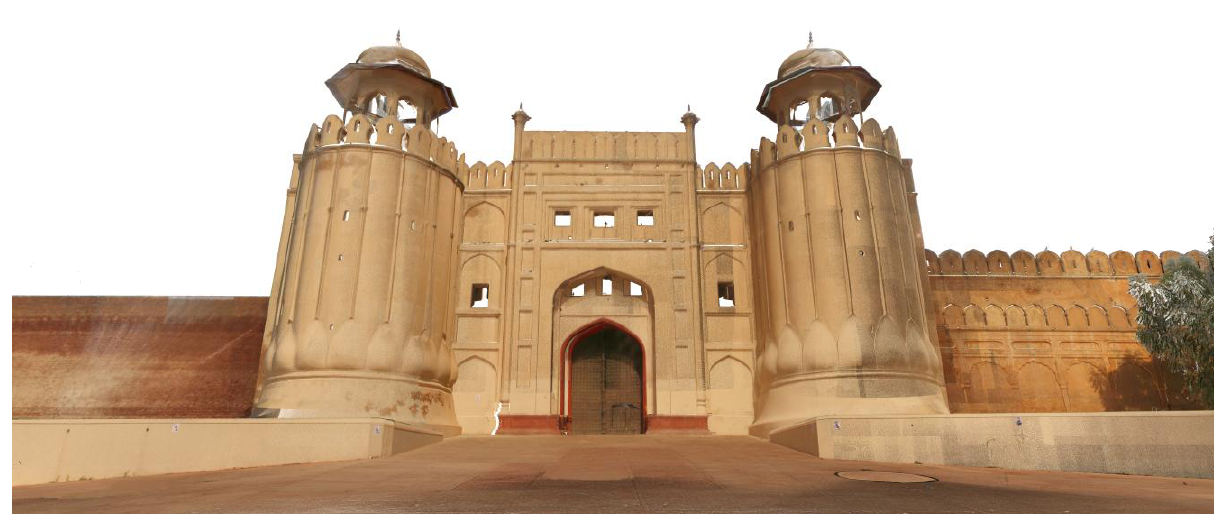
Figure 13. Alamgiri Gate 3D